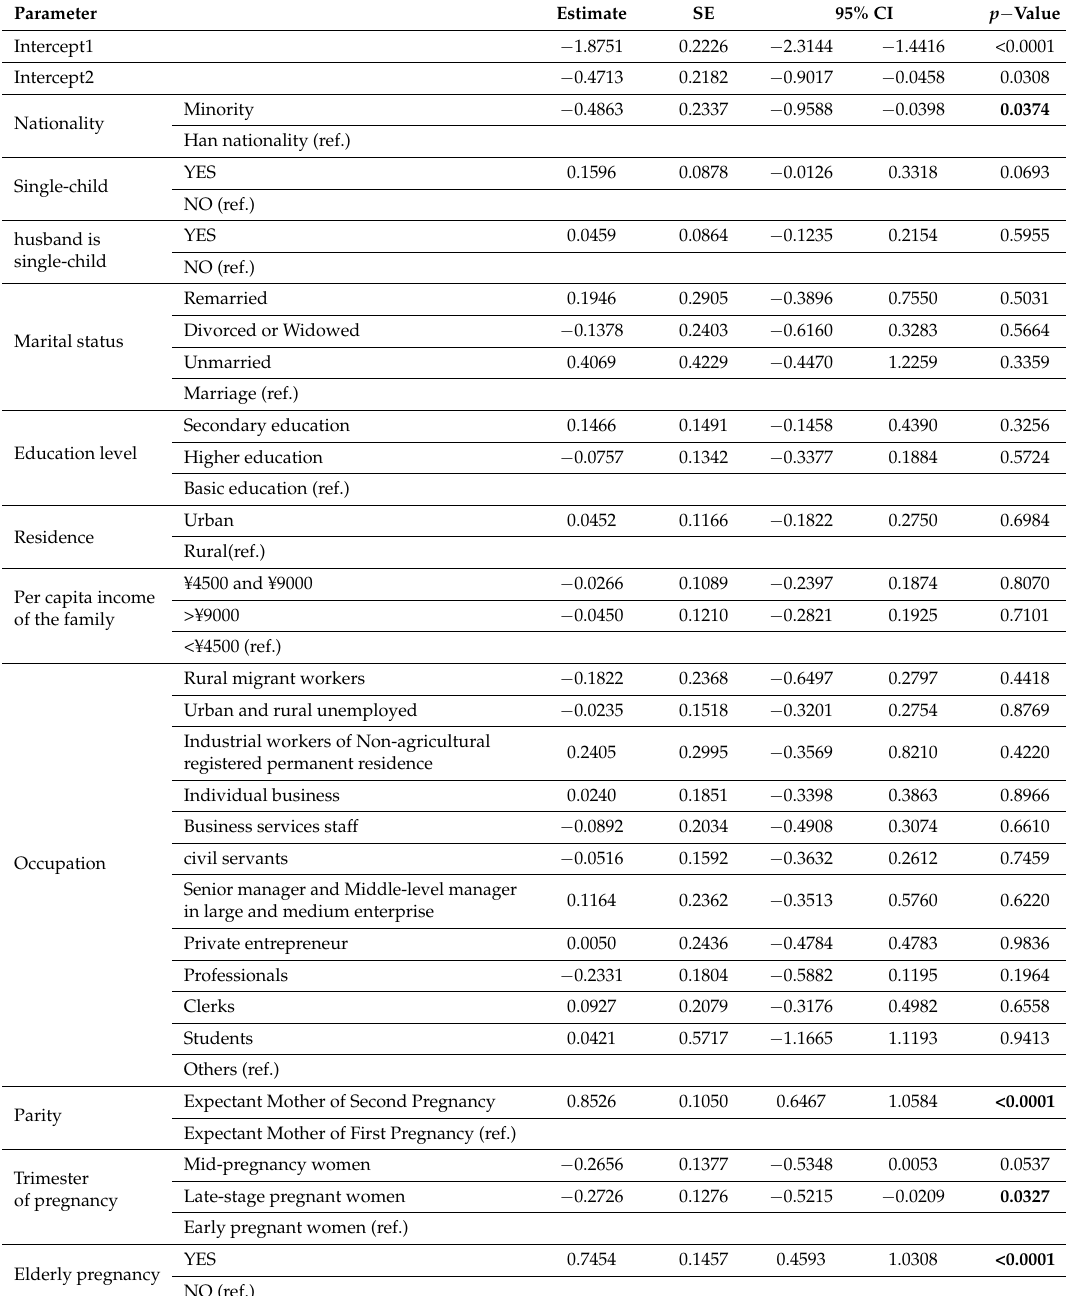
Table 2. Ordered Multivariate Logistic Regression for caesarean delivery